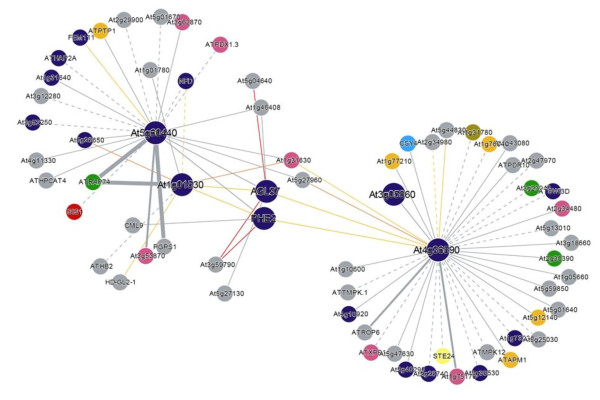
Interaction map for the AGLs overexpressed in 'big seeds'. Big blue circles represent the 5 AGLs overexpressed in the 2 × 6 and fis1X2x crosses.